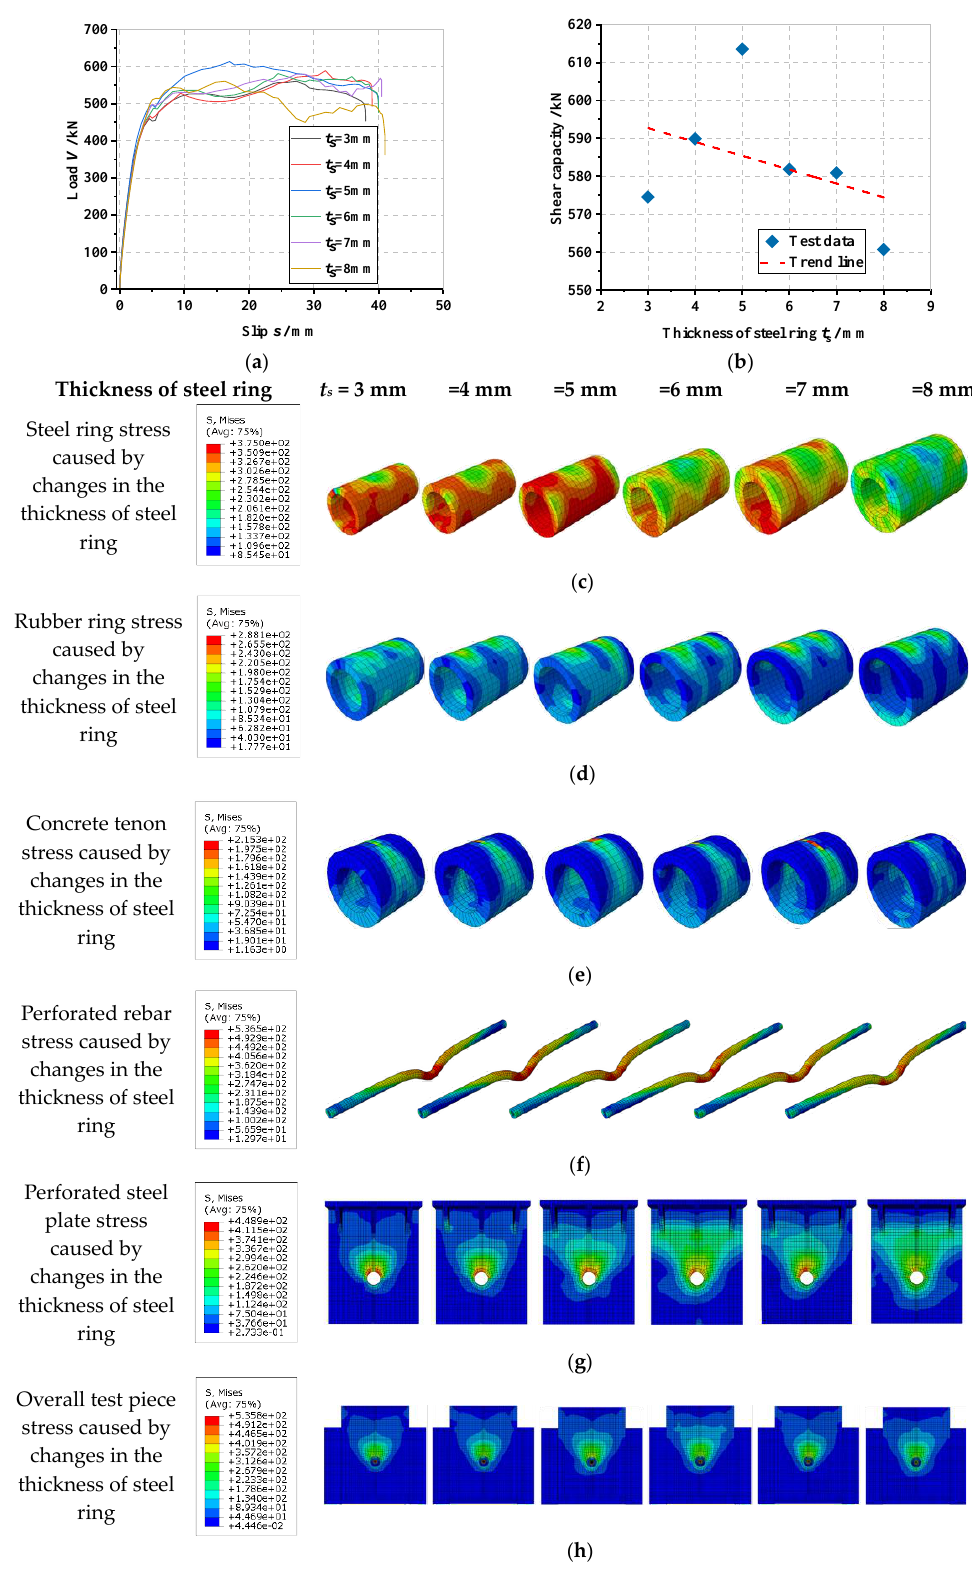
Figure 10. Influence of steel ring thickness: ( a ) overall load–slip curves, ( b ) impact analysis, ( c ) steel ring stress, ( d ) rubber ring stress, ( e ) concrete tenon stress, ( f ) perforated rebar stress, ( g ) perforated steel plate stress, ( h ) overall stress in the specimen.